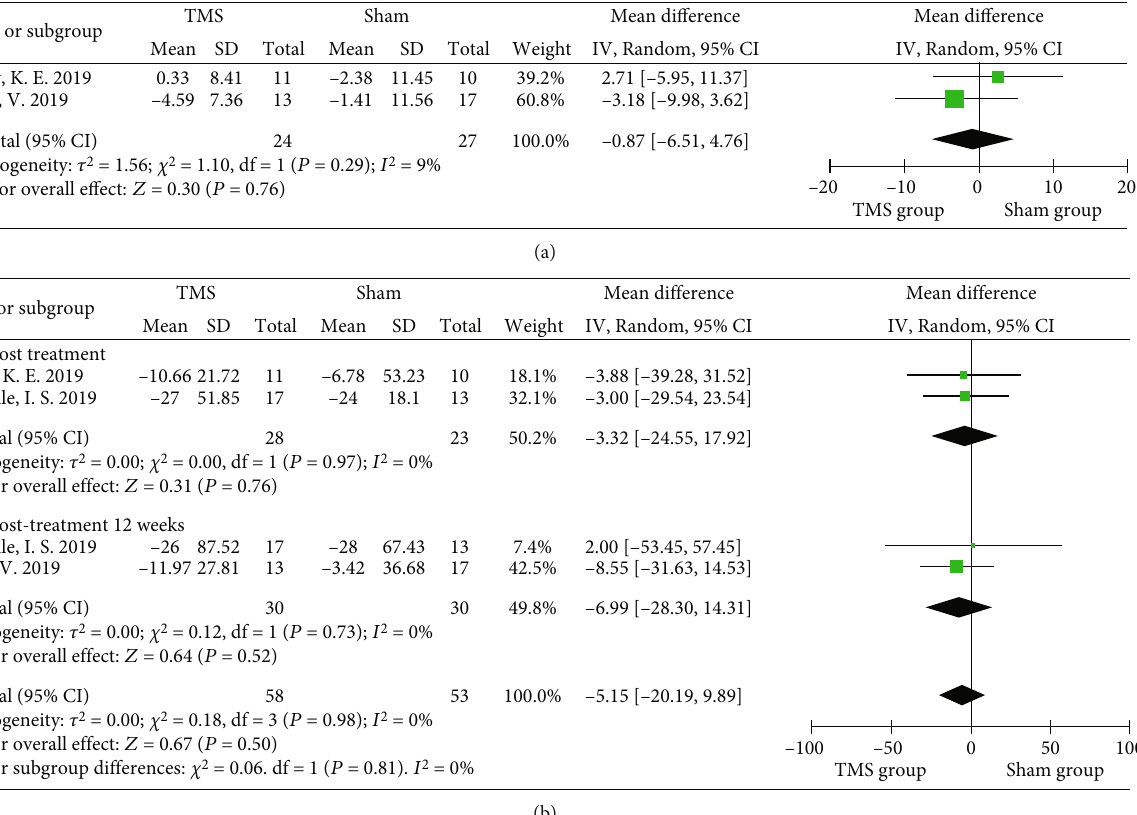
Figure 8: Forest plots of di ff erent parts of rTMS on cognition measured by the TMT-A and TMT-B in TBI patients: (a) the TMT-A; (b) the TMT-B. TMT: Trail Making Test.